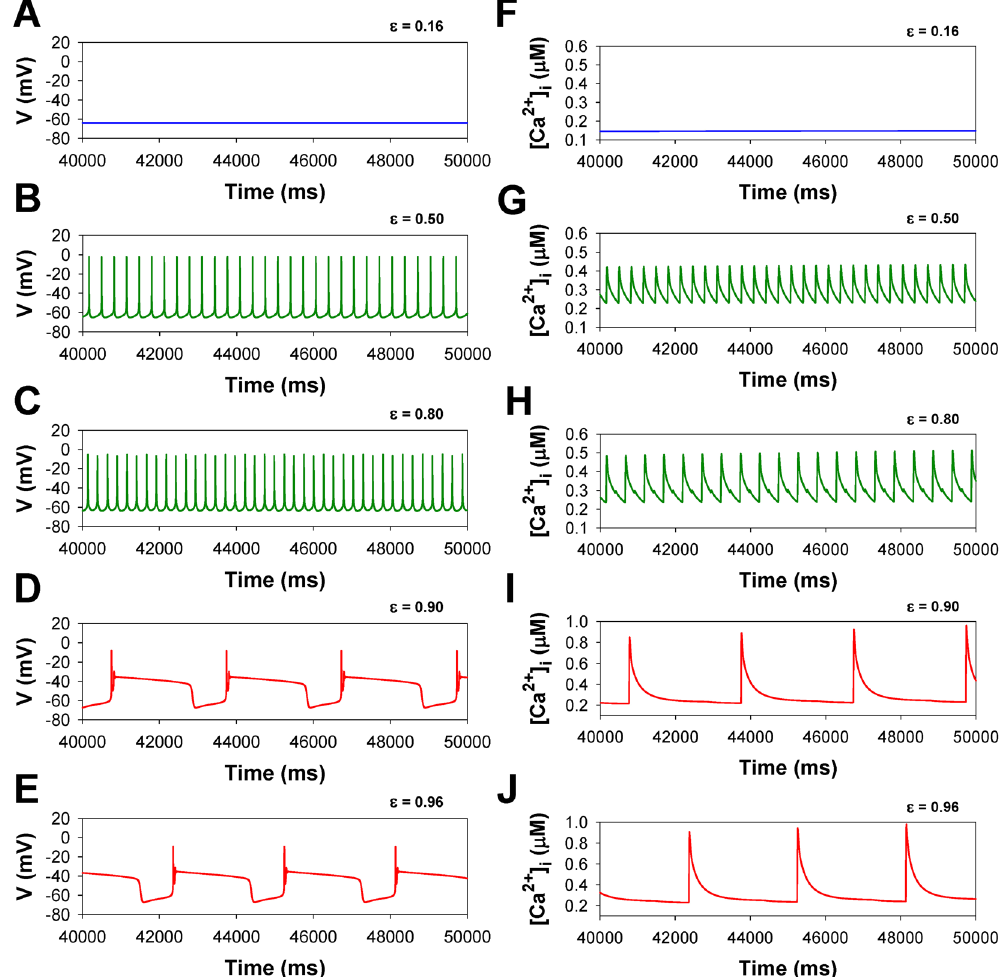
Figure 9. Simulated time series of AP (Panels A–E) and [Ca 2 + ] i transients (Panels F–J) in characteristic points of bifurcation diagrams for mouse ventricular myocytes in Fig. 8 at different values of ε during transition from WT to TNF- α overexpressing mouse ventricular myocyte: ε = 0.16 (Panels A,F); ε = 0.50 (Panels B,G); ε = 0.80 (Panels C,H); ε = 0.90 (Panels D,I); ε = 0.96 (Panels E,J);. I Na with slow